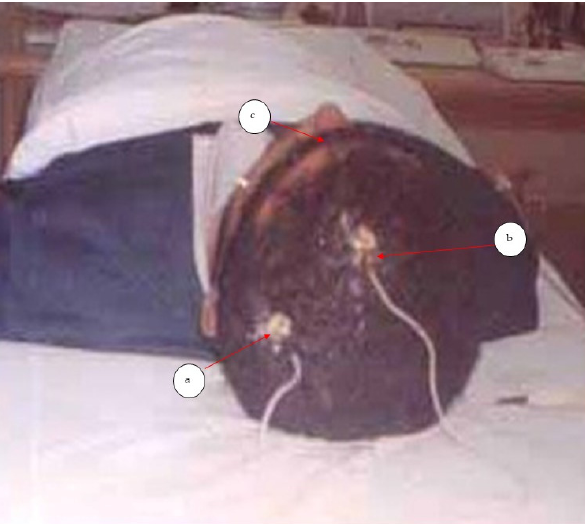
Figure 3. Sites of Recording: ( a ) active recording electrode at c3’, ( b ) reference electrode at Fz, and ( c ) grounding electrode at Fbz.